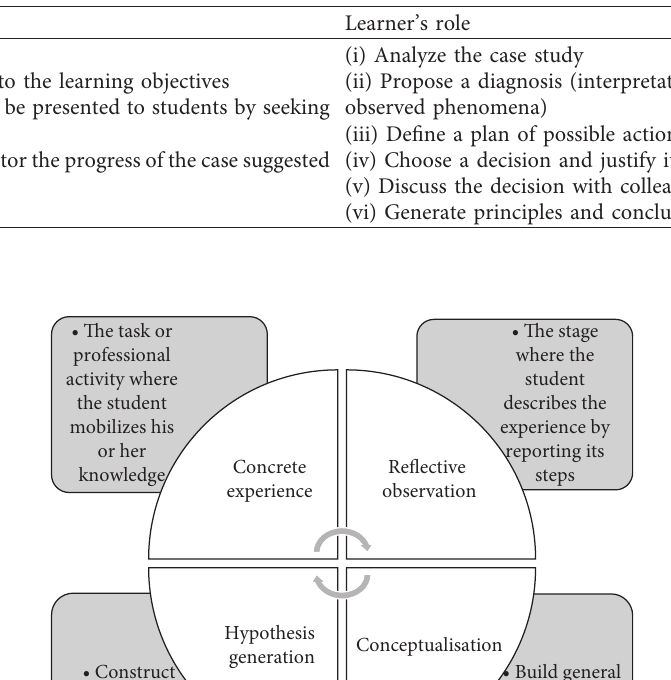
Table 2: Different roles of instructor and learner.